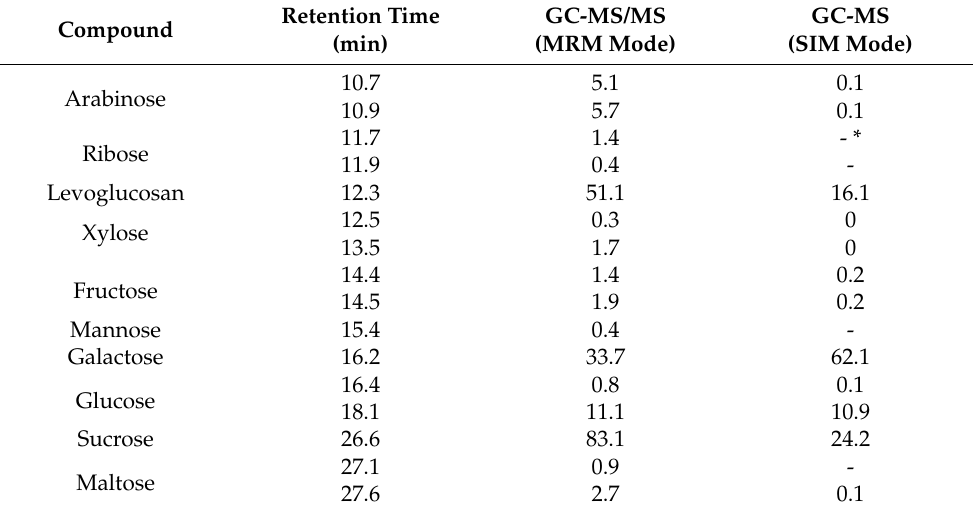
Table 7. Signal-to-noise ratios of target saccharides in sample #11 when using GC-MS/MS and